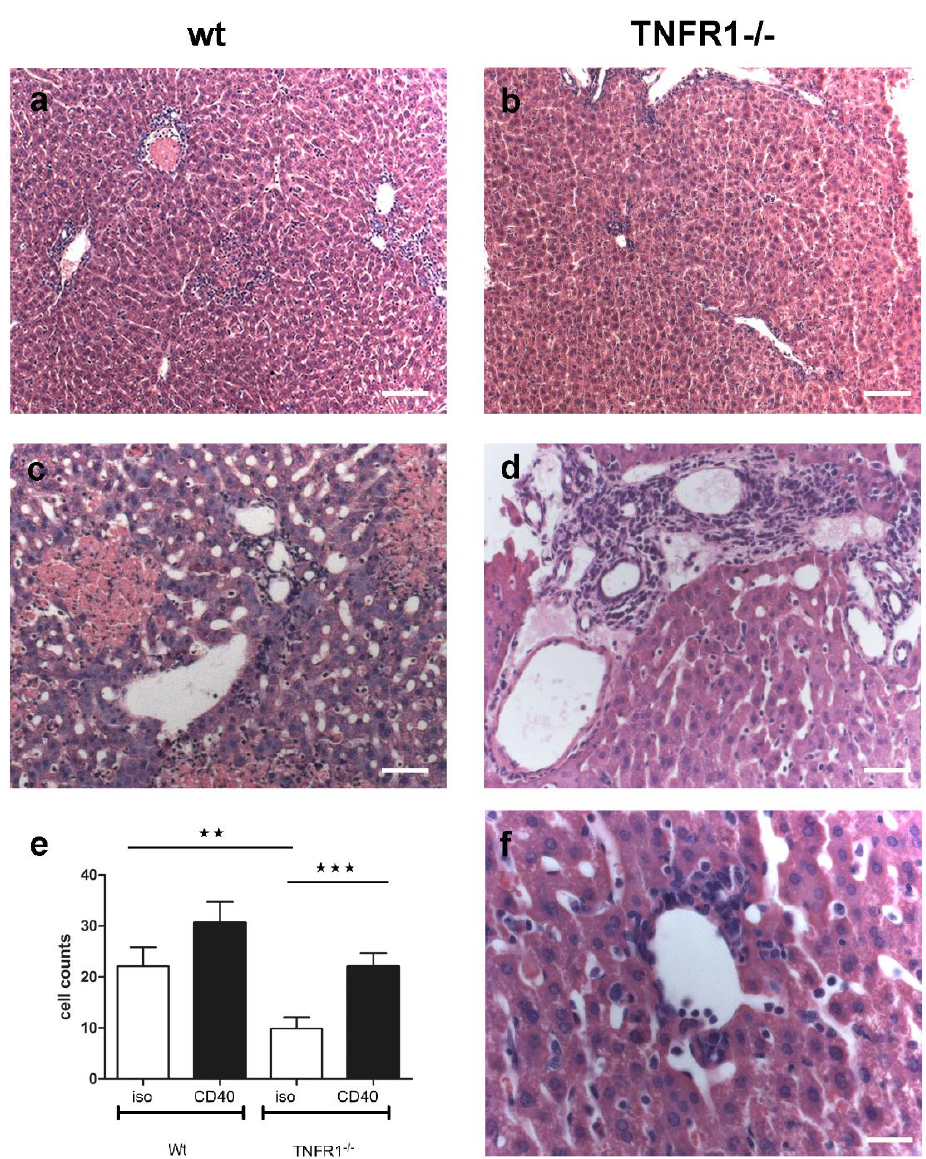
Figure 3. Light microscopic analysis of hepatic tissue sections of wt ( a , c ) and TNFR1 − / − mice ( b , d , f ). ( a – d , f ) HE-stained liver tissue from CD40 mAb activated ( a , c ) wt and ( b , d , f ) TNFR1 − / − mice. Bars: ( a , b ): 500 µ m, ( c , d ): 200 µ m. ( f ): 100 µ m. ( e ) Semiquantitative analysis of cell counts on the HE-stained sections of isotype (white columns) and CD40 mAb-treated (black columns) mice. ** p = 0.006, *** p = 0.0008. Error bars: S.E.M.